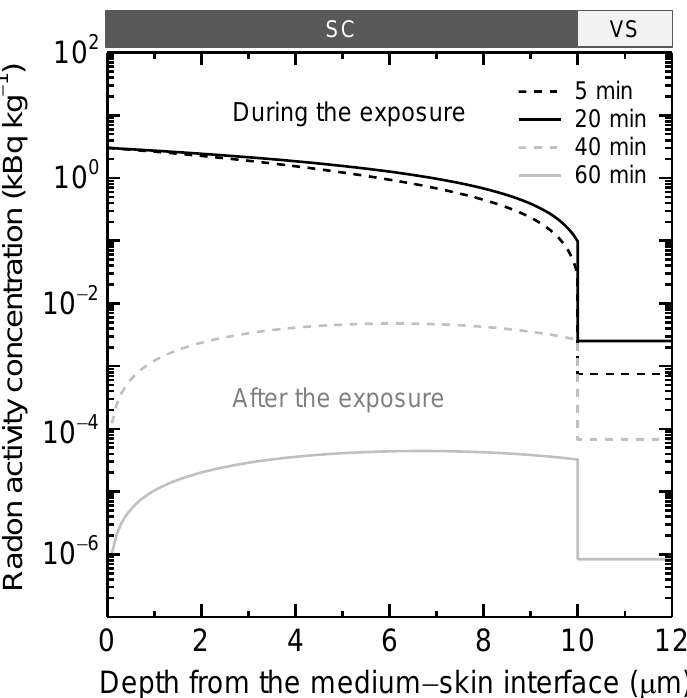
Figure 4. Radon activity concentrations in the skin at different depths during and after immersion in thermal water. The following were the radon exposure parameters: 0 – 20 min with the exposure only from thermal water (100 Bq l −1 ; 37 °C); 20 – 60 min without exposure from thermal water and air; male subject; D SC = 6.4 × 10 − 14 m 2 s − 1 (median of D SC for males, assessed from the human study of Nagy [16]). The stratum corneum (SC) was assumed to be 10- μm thick, and the deeper part was the viable skin (VS), where the radon activity concentration was assumed to be uniform, with a typical thickness of 1000 –2000 μm [15] that is not used as an input parameter for the modeling.